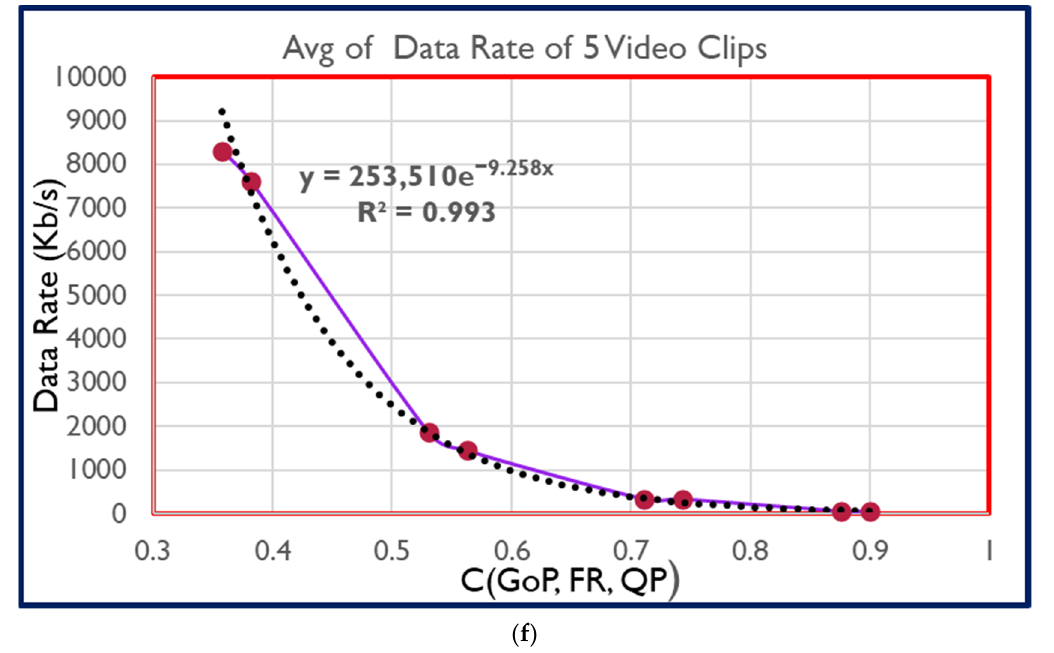
Figure 5. Impact of three parameters on the data rate of traffic shaping: ( a ) QP impact; ( b ) GOP impact; ( c ) FR impact; ( d ) Impact of the combination of the two parameters GOP and FR; ( e ) Impact of the combination of the three parameters GOP, FR, and QP; ( f ) The average of the data rate and the equation derivation for the impact of C(GOP, FR, and QP).